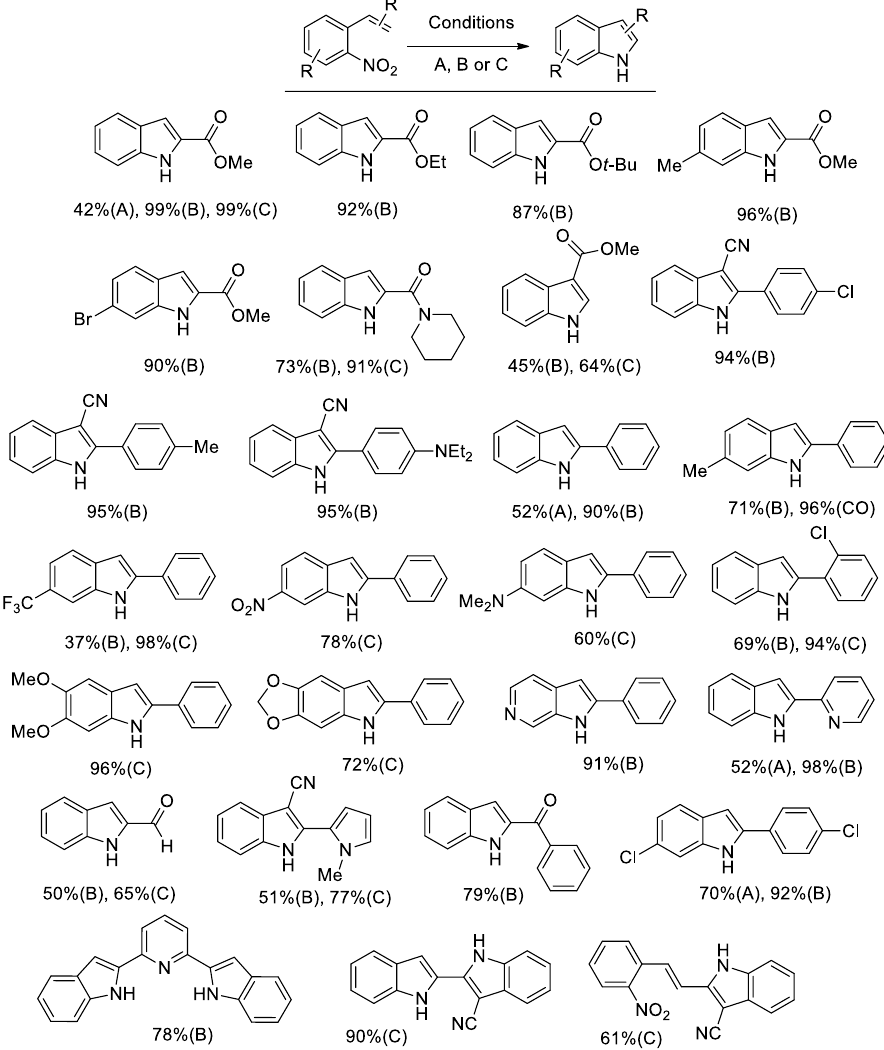
Figure 1. Indoles from o -nitrostyrenes. Conditions A: 0.27 mmol nitrostyrene, mol. 1 mol